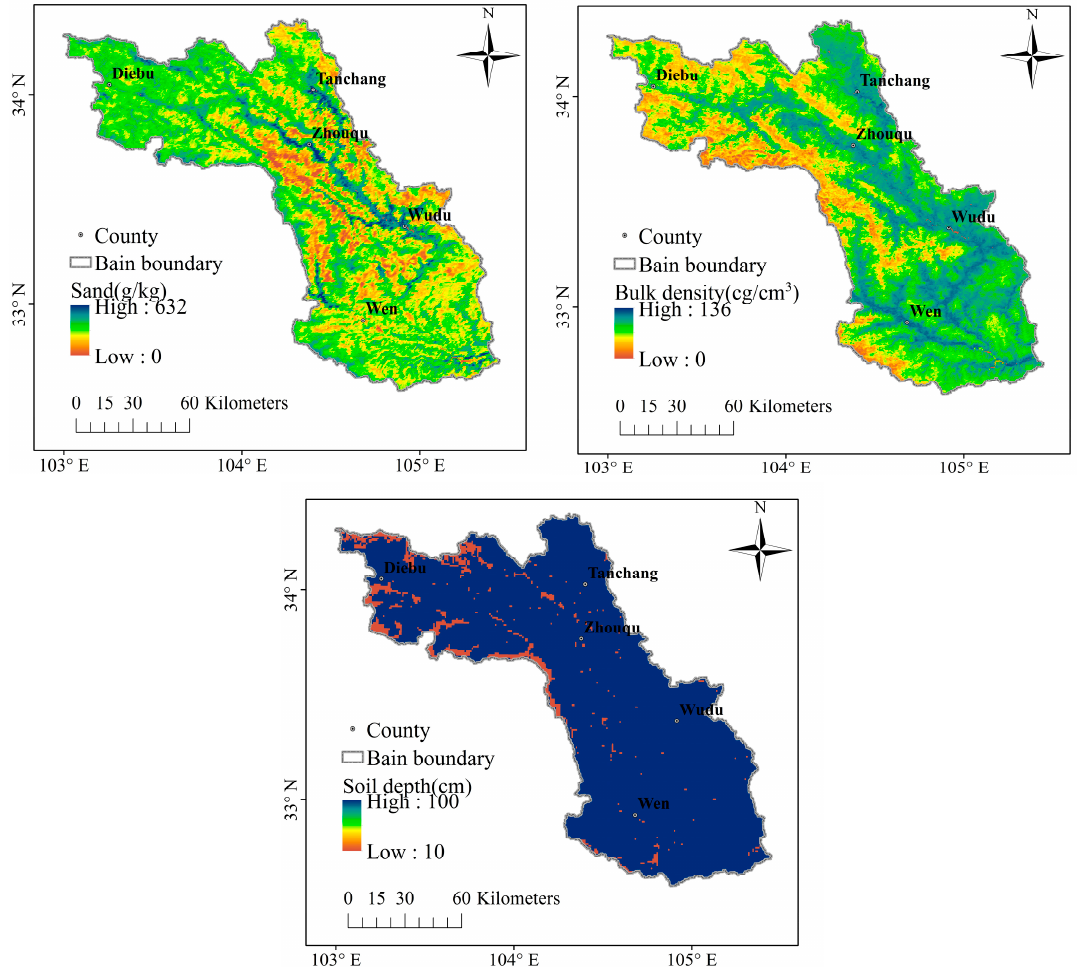
Figure 5. Distribution of factors related to vegetation and soil.